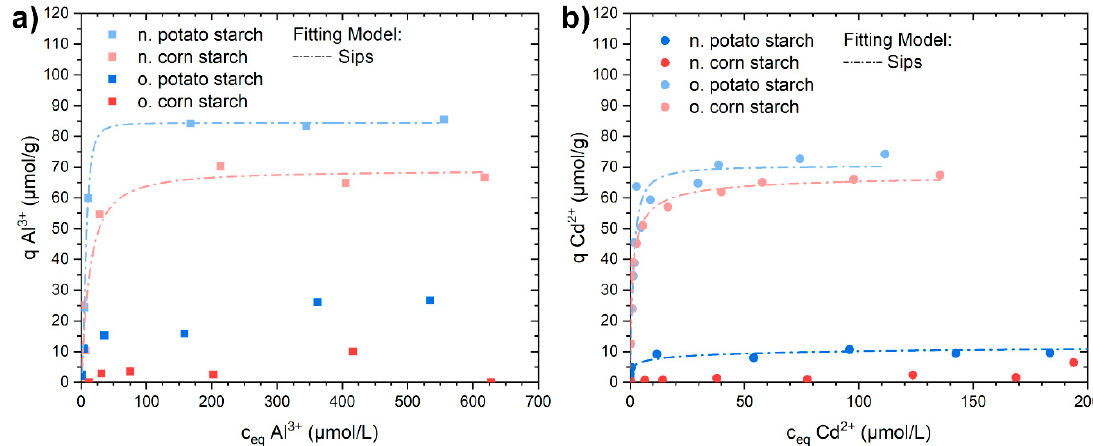
Figure 9. Adsorption capacity ( a ) for Al 3+ from Al 2 (SO 4 ) 3 solution and ( b ) for Cd 2+ of CdSO 4 solution and corresponding Sips isotherm model fits. Native potato starch is shown in blue, native corn starch in red, oxidized potato starch in light blue, and oxidized corn starch in pink. The corresponding SO 42- adsorption and pH values can be seen in Figure S22 for the experiment with Al 2 (SO 4 ) 3 solution and Figure S23 for the experiment with CdSO 4 solution. Native potato starch did not exhibit a viable fitting for Sips model in the Al 2 (SO 4 ) 3 sorption experiments. Native corn starch (red) did not exhibit a viable fitting for Sips model (R 2 < 0.7) for both isotherms.